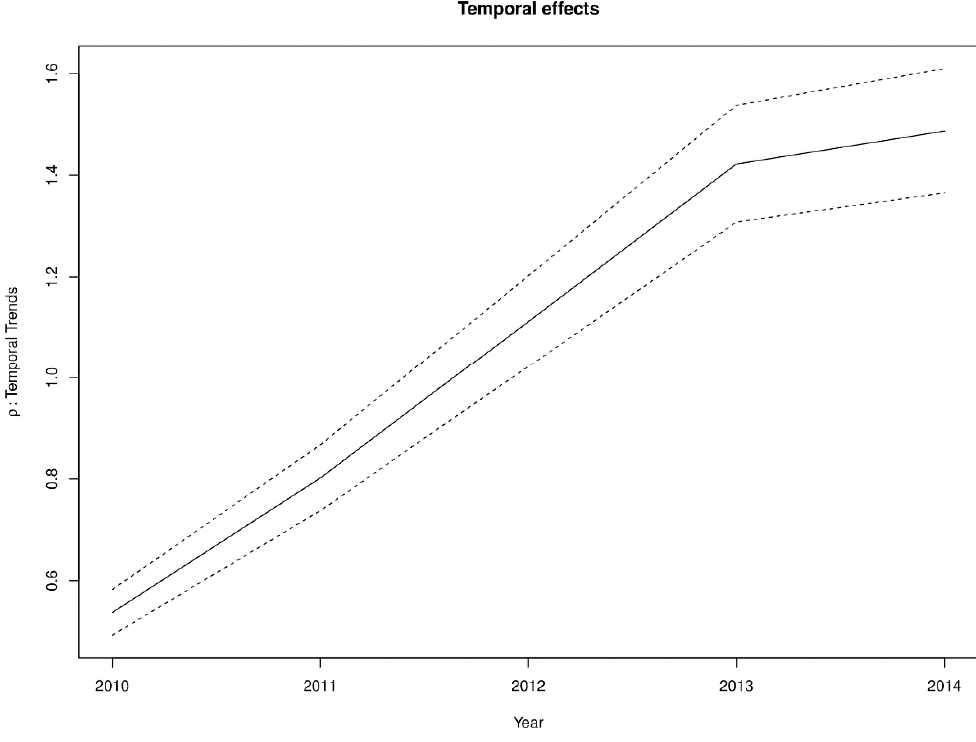
Figure 8. First-order random walk patterns of intestinal parasites risk from 2011–2014.